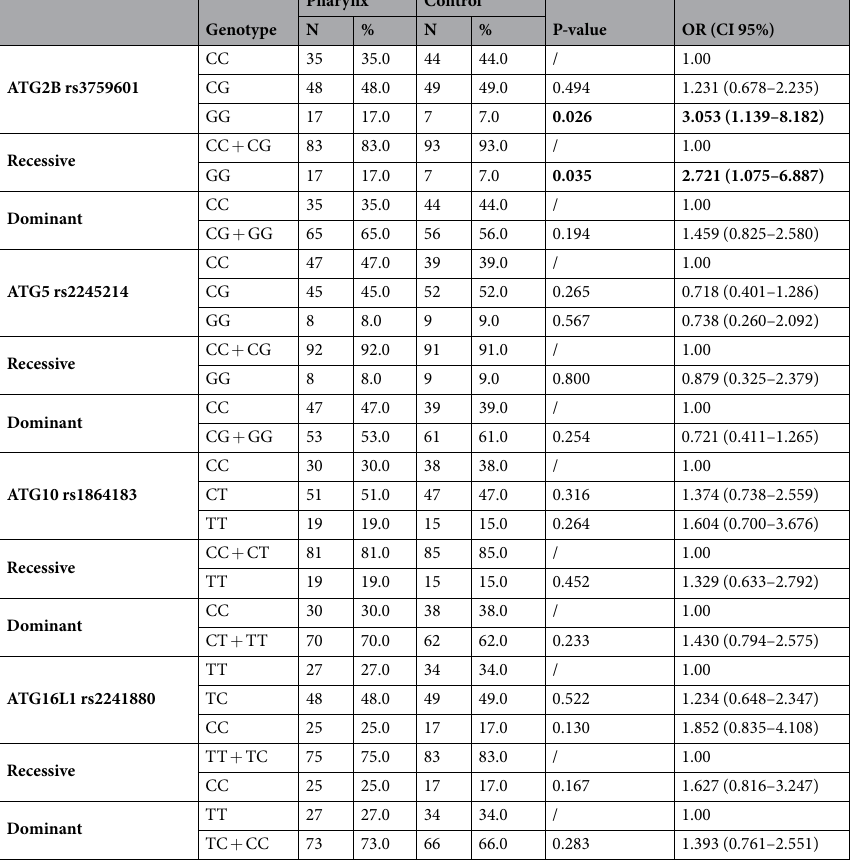
Table 6. Comparative results in selected ATG polymorphism distribution in risk factor-matched pharyngeal cancer and controls. Statistically significant results in